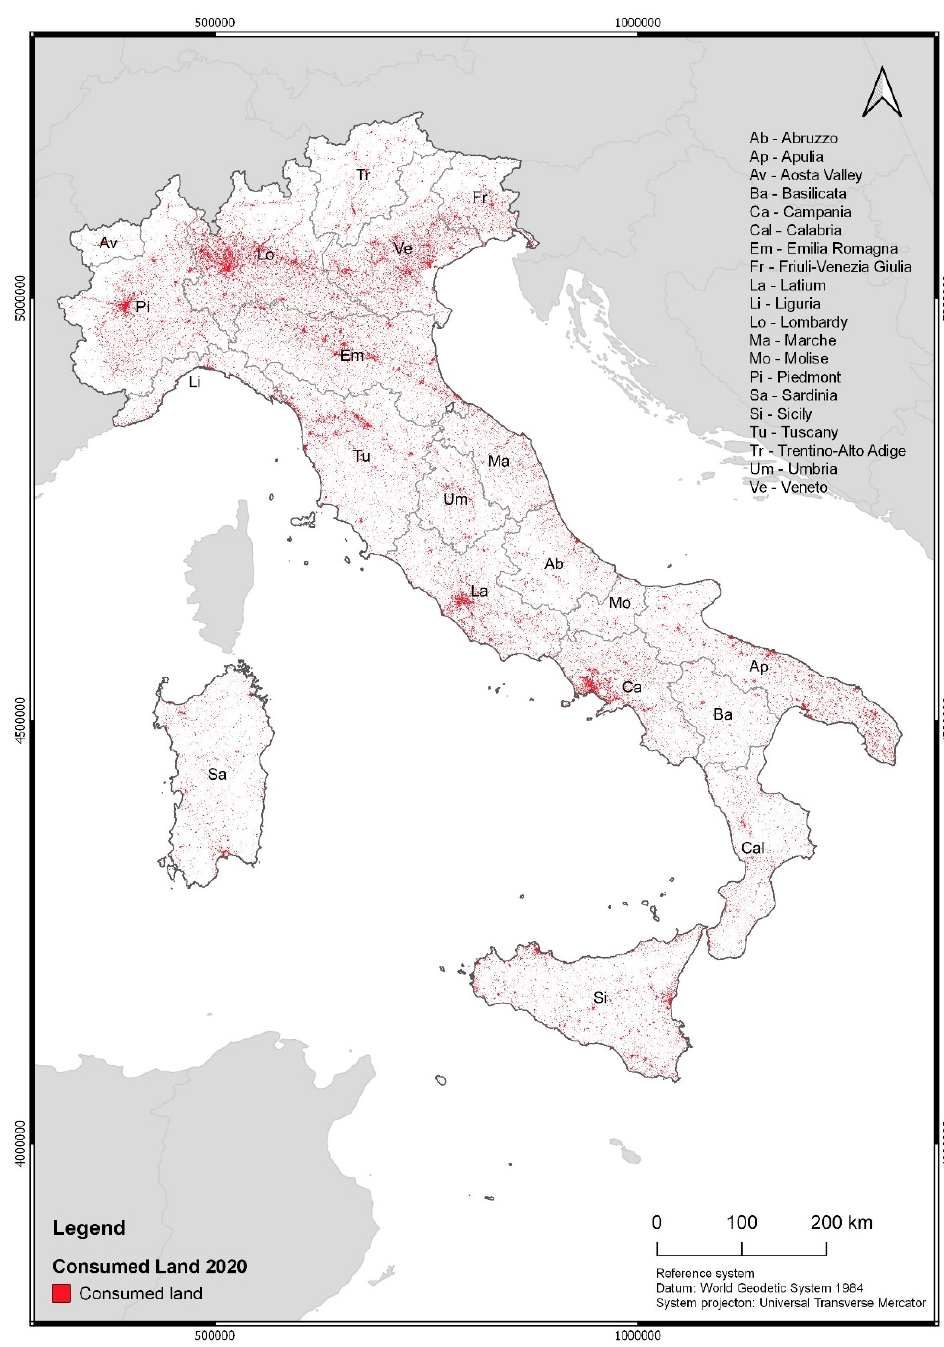
Figure 2 . Land consumption map for Italy (year 2020). Figure 2. Land consumption map for Italy (year